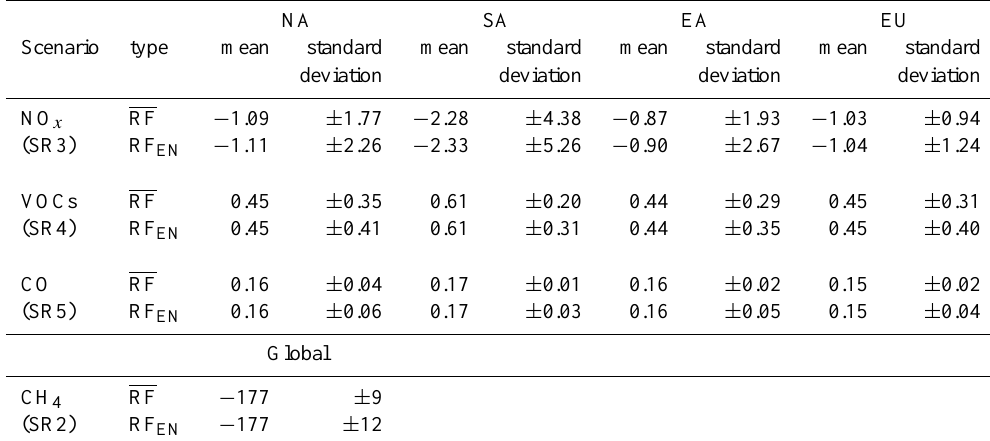
Table 3. Total RF per unit mass emission (mWm − 2 ( Tgyear − 1 ) − 1 ) for each scenario. The standard deviation values given for RF EN are the RF resulting from the Fry-method subset mean and standard deviation short-lived ozone, methane and long-lived ozone fields, as described in Sect. 3. The true standard deviation values for RF are calculated after the total RF for each model in each scenario has been calculated; therefore they are not equal to the sum of the standard deviation for each component gas. For the CH 4 case, results are presented un- normalised, in mWm − 2 , since the perturbation was a 20% reduction in atmospheric concentration of methane, rather than a reduction in precursor emissions.